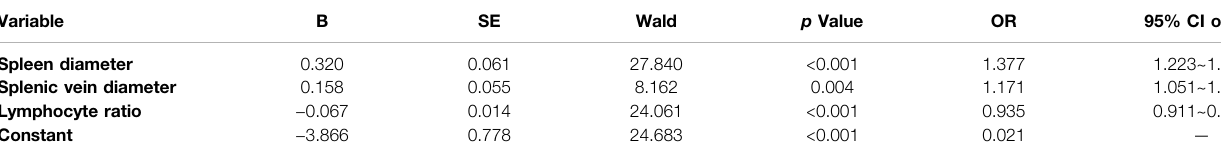
TABLE 5 | Variables used to establish the prediction model for the presence of red signs. Variable B